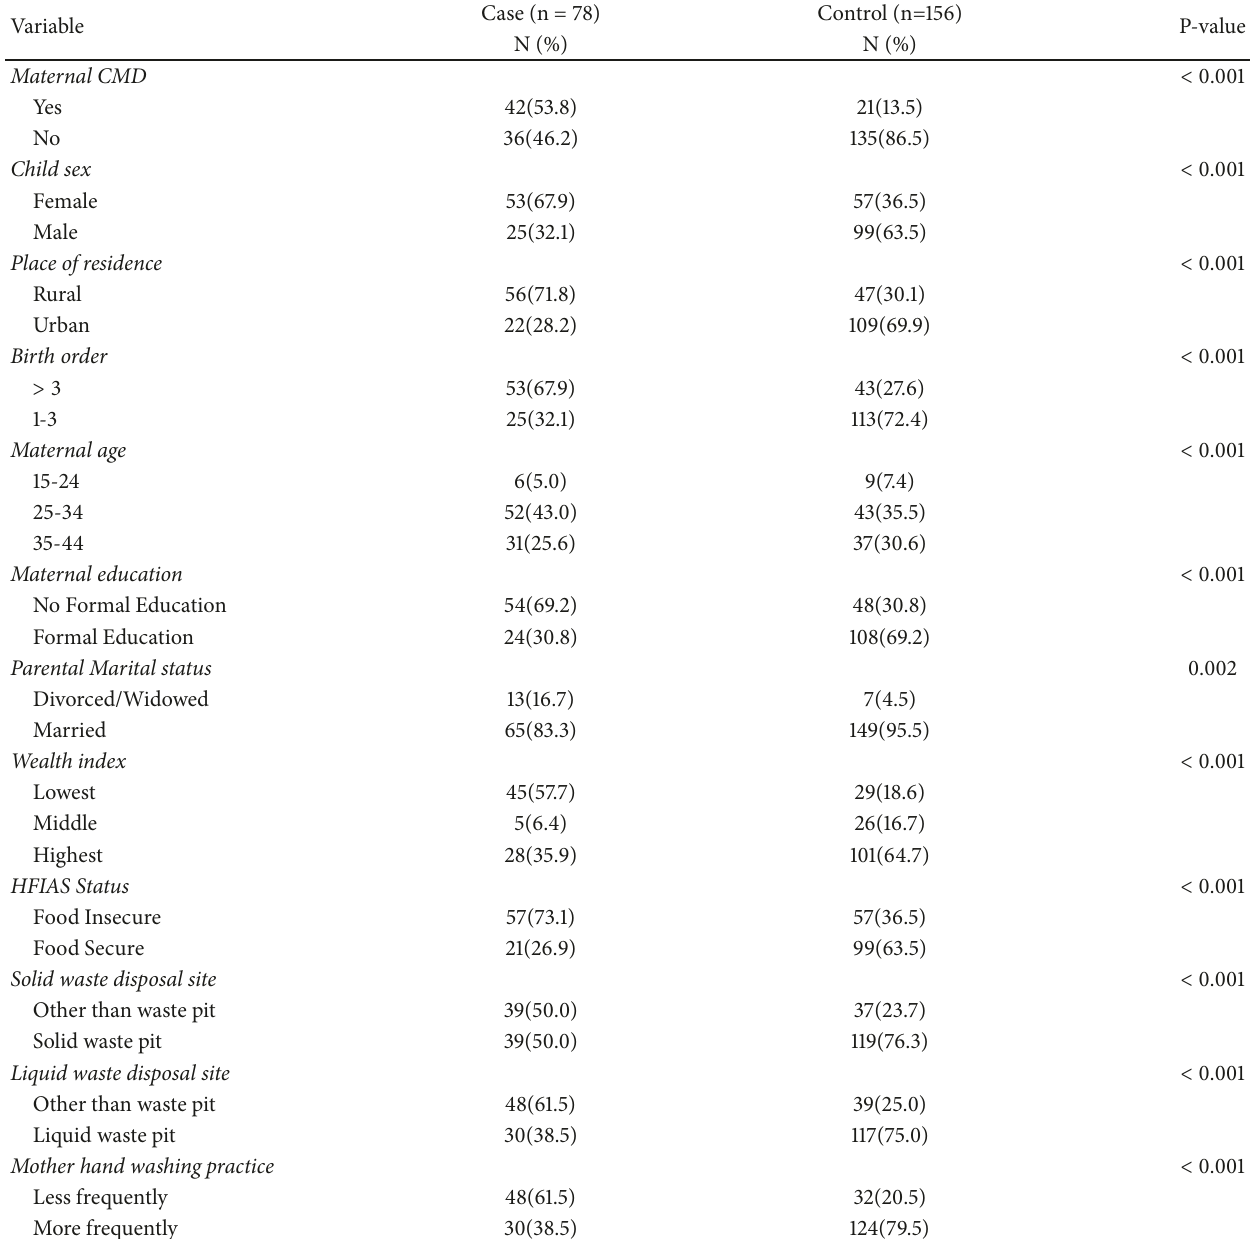
Table 1: Background characteristics of study population of Nekemte town, West Ethiopia,